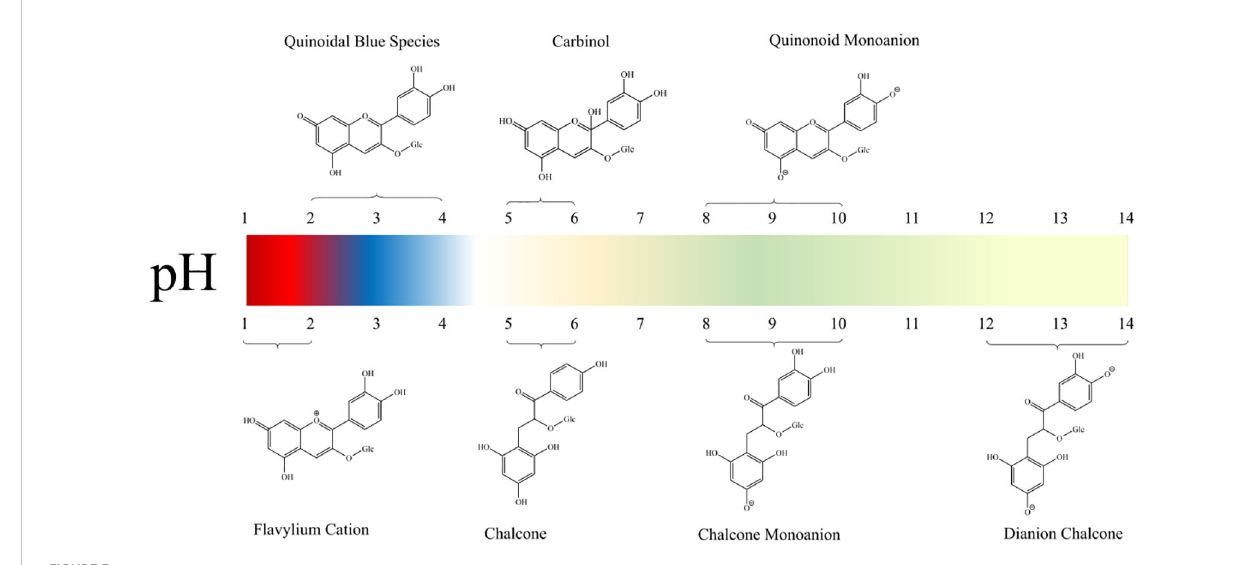
FIGURE 3 Color of anthocyanins at different pH